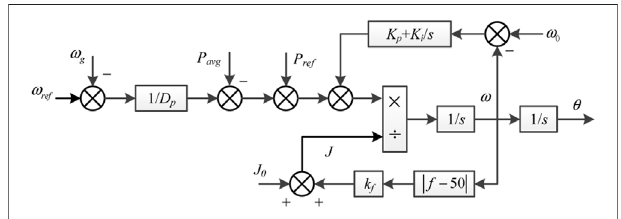
FIGURE 5 | Adaptive rotational inertia control block